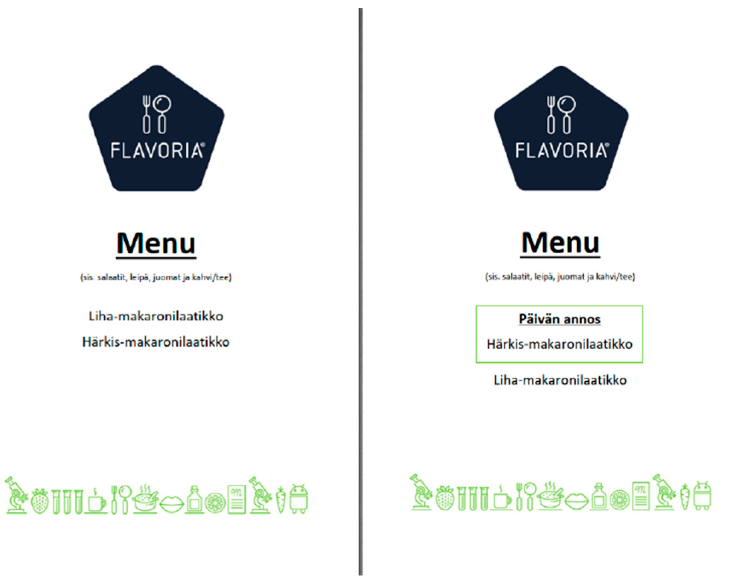
Figure 2. The standard menu ( left ) and Dish of the Day ( in Finnish “Päivän annos” ) ( right ) menu. The Finnish text “ sis. salaatit, leipä, juomat ja kahvi/tee ” can be translated as “including salads, bread, drinks, and coffee/tea” into English. The Finnish words Liha-makaronilaatikko and Härkis-makaronilaatikko refer to minced meat casserole and fava bean casserole.